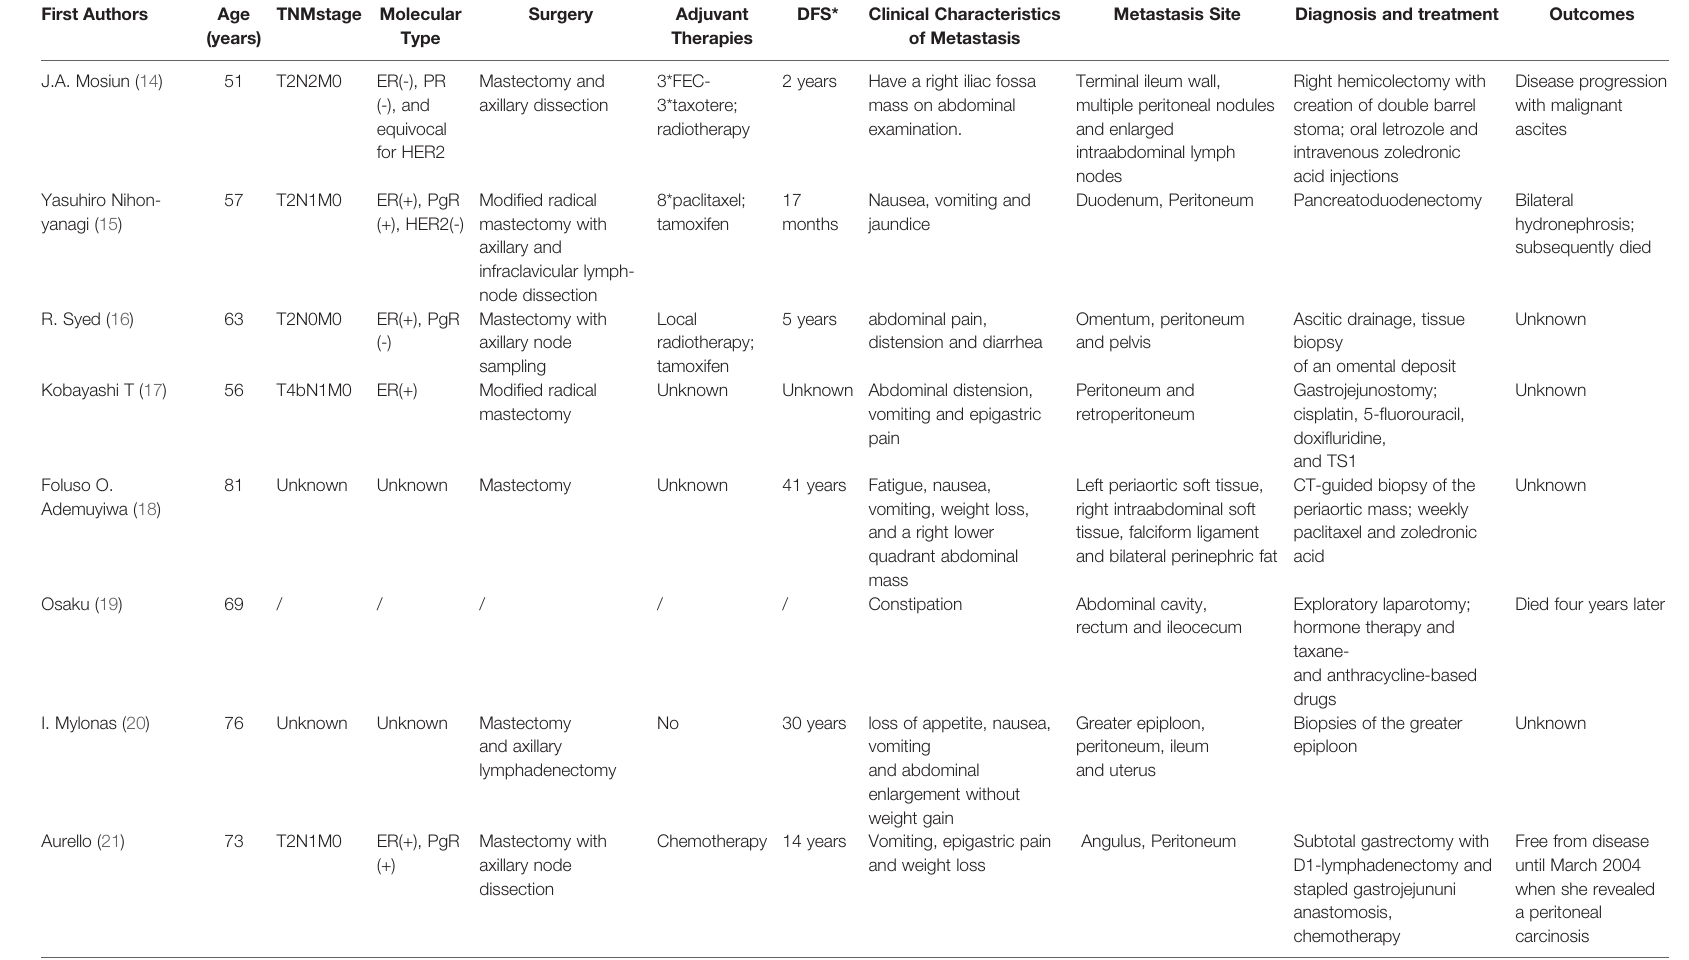
TABLE 1 | Review of literature: characteristics and outcomes of breast cancer patients with peritoneal metastasis. First